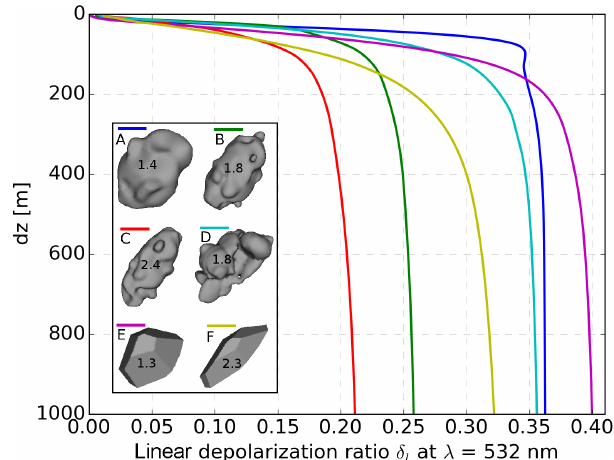
Figure 5. Linear depolarization ratio profiles at λ = 532nm in the upper 1km of the SAL for [H1, 5d]. The reference ensemble is ap- plied (as in Fig. 4), but only a single dust particle shape is assumed in each profile as indicated in the legend. The approximate aspect ratio is written on each